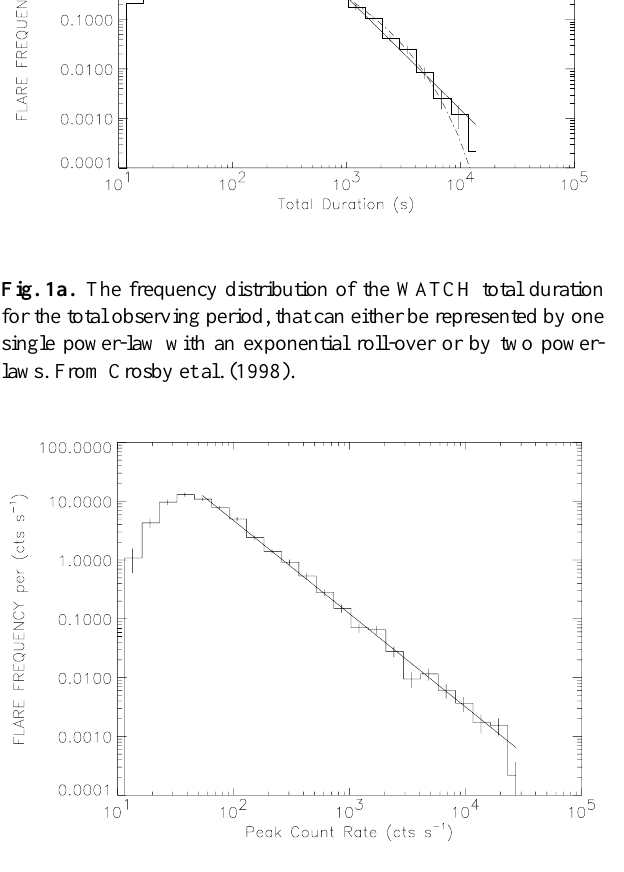
Fig. 1b. The frequency distribution of the WATCH flare peak count rate for the total observing period, that is well-represented by a power-law above the turn-over at 100cs − 1 with a slope − 1.59 ± 0.02. From Crosby et al. (1998).